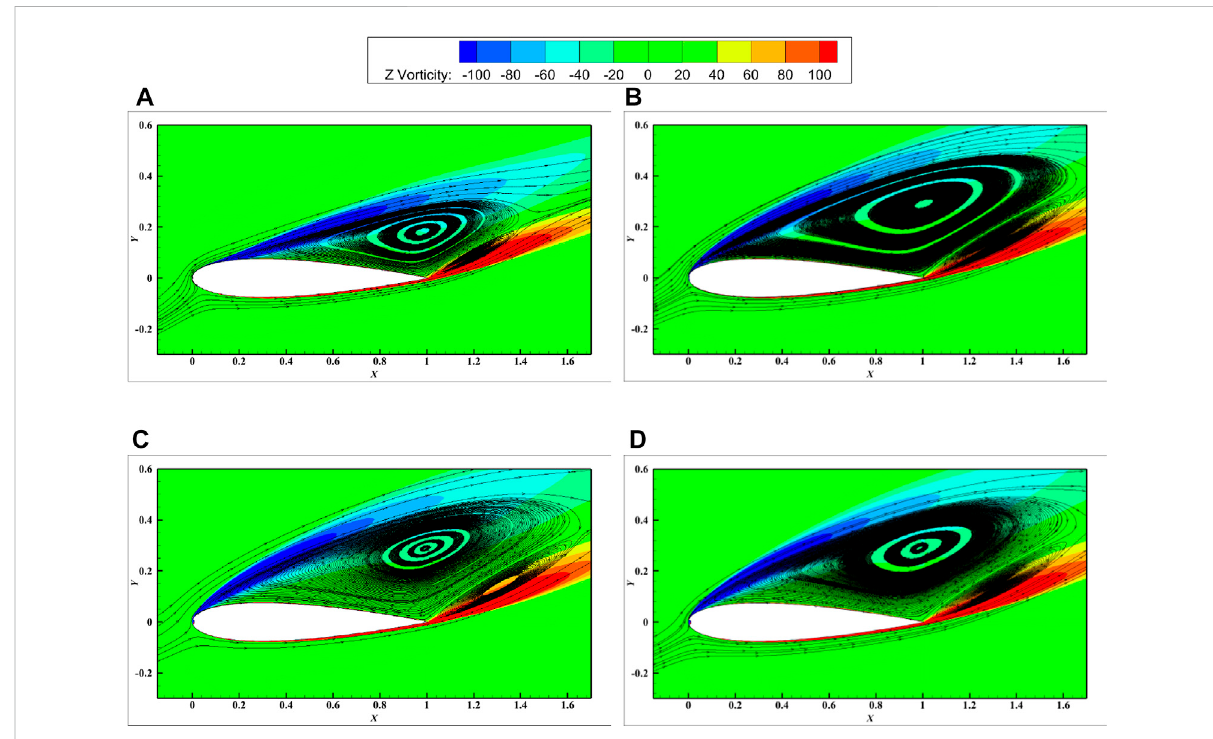
FIGURE 23 Surface streamlines and vorticity of NACA0015 airfoil with different erosion patterns at 18 ° angle of attack. ( (A) : Semicircular erosion ( h 1 = 0.3% c ); (B) : Square erosion ( h 2 = 0.3% c ); (C) : Semi-circular erosion ( h 1 = 1% c ); (D) : Square erosion ( h 2 = 1% c